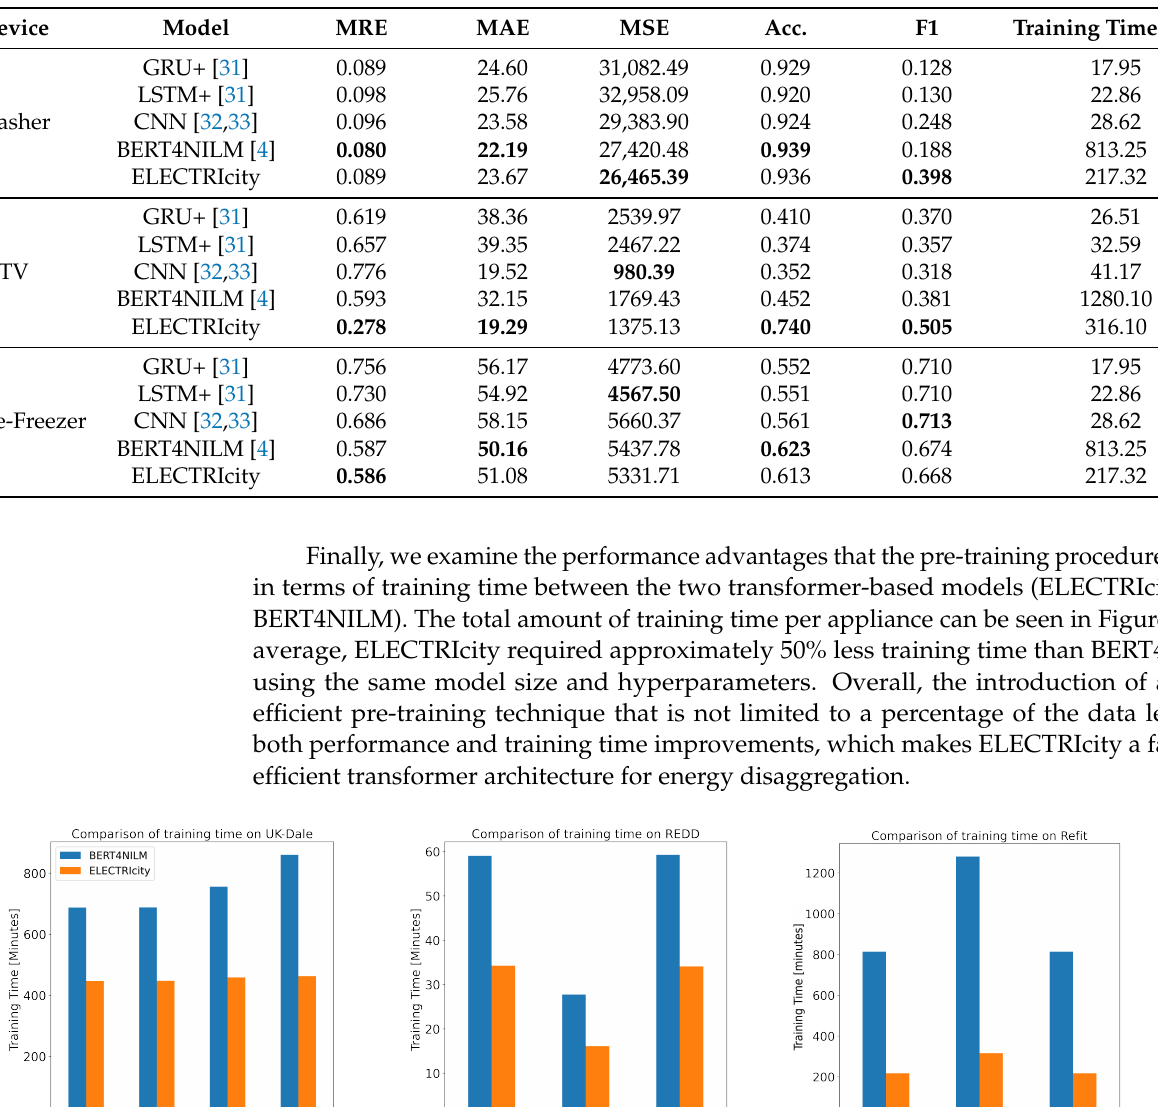
Table 4. Comparison of ELECTRIcity’s model performance to other techniques in the Refit dataset.